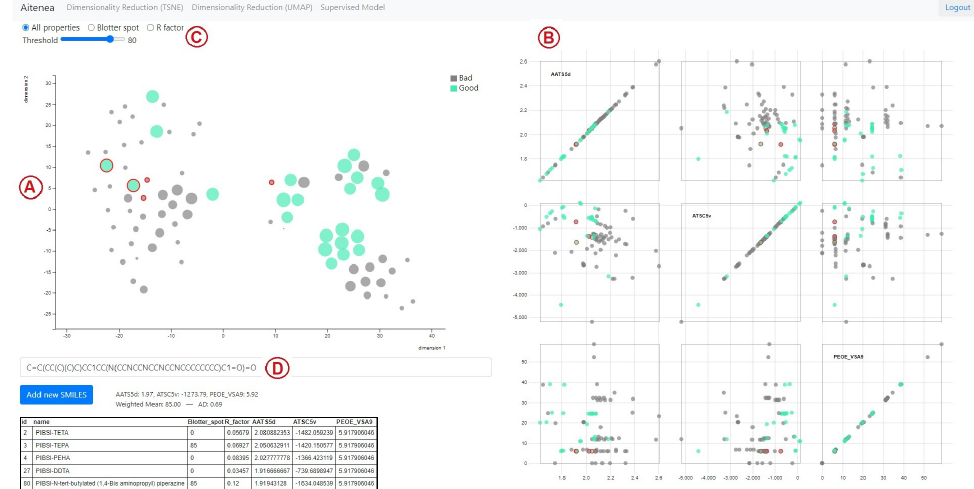
Figure 1. Interface for the model based on structural similarity distances using t-SNE. ( A ) 2D projection of our compounds. ( B ) Scatterplot matrix. ( C ) Filtering of compounds. ( D ) Neighborhood for new compounds. The nodes in green represent the compounds with ‘high’ blotter spot values, i.e., those above the predefined threshold (set as 80 in this plot). The five most structurally similar compounds to the candidate compound are highlighted using a red outline, and their information is summarized in the table included below the t-SNE plot. On the right, scatterplots for pairwise analysis of descriptors are shown, where the descriptor values of the five nearest-neighbors of the candidate are highlighted using a red